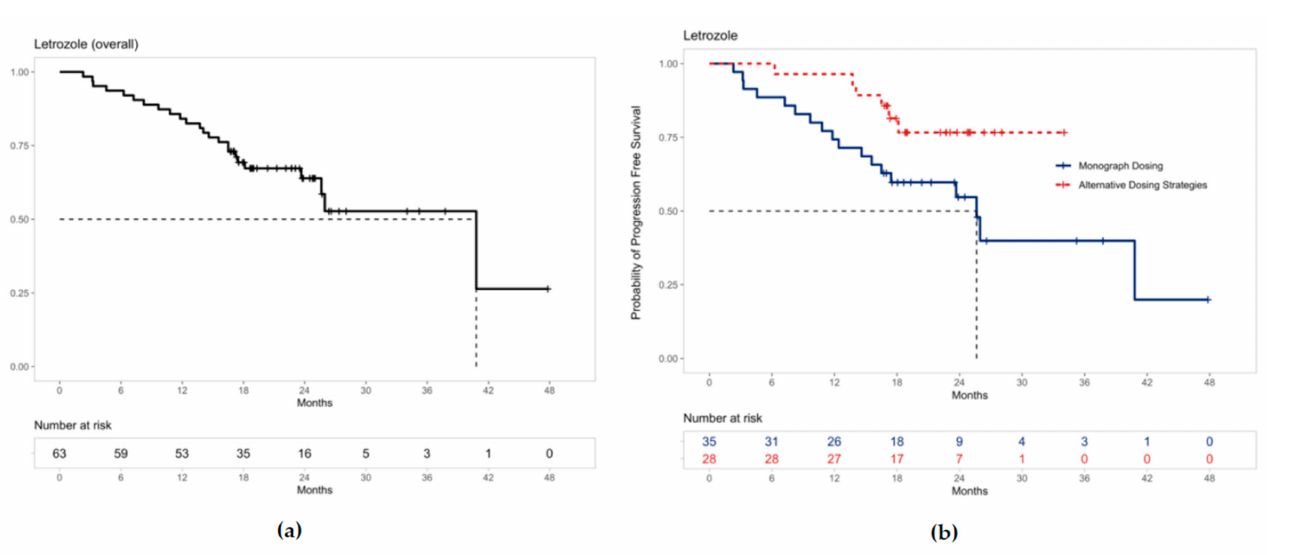
Figure 3. Progression-free survival for patients receiving palbociclib with letrozole: ( a ) The median PFS was 40.8 months (95% CI 25.6–not estimable) for all patients receiving palbociclib with letrozole. ( b ) The median PFS for patients receiving letrozole with palbociclib prescribed monograph